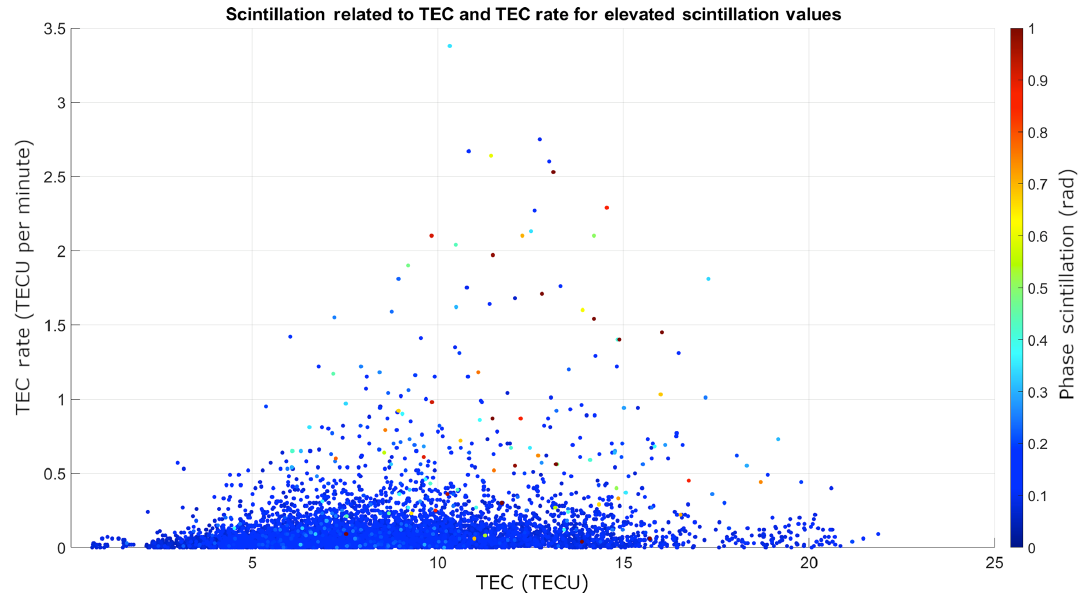
Figure 12. Phase scintillation as a function of TEC and the TEC rate of change per minute for 17 December 2014, 12 December 2015, and 10 December